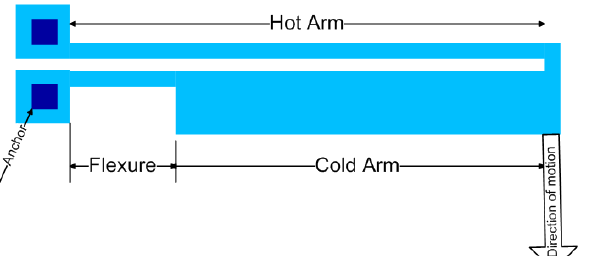
Figure 1 . Hot/cold arm thermal actuator.